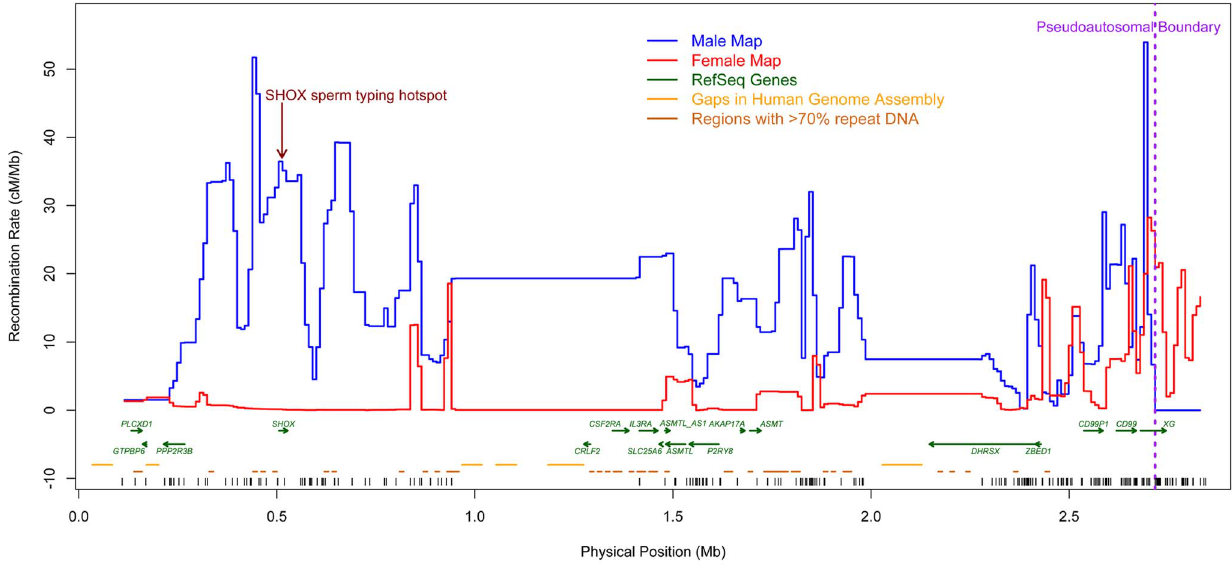
Figure 1. New sex-specific pedigree-based genetic maps (10 kb scale). The male map (blue) shows intense crossover activity throughout PAR1, with particularly high rates towards the telomeric end. Fine-scale variation in rates could not be estimated in two regions ( * 1–1.4 Mb and * 2– 2.25 Mb, build 36) due to large unmapped and repetitive sequences and lack of genotyped SNPs. The female map (red) has a low rate through much of PAR1, and a trend of increasing rate towards the pseudoautosomal boundary. Vertical black tick marks show marker